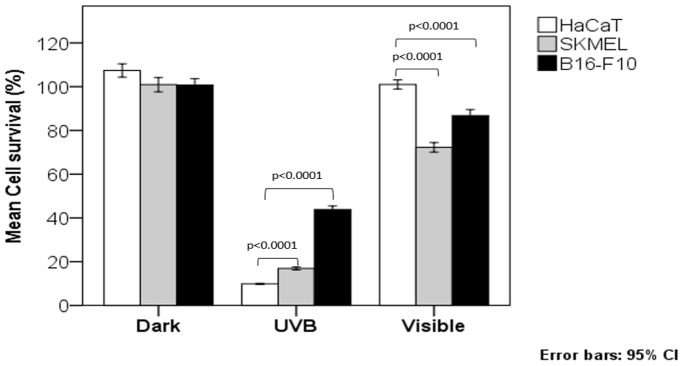
The effects of UVB and visible light on cell viability.The cell viability (MTT) of HaCaT, SK-mel and B16-F10 cells maintained in the dark (control) or irradiated with UVB (4.5 J.cm−2) or visible (36 J.cm−2) light. The color of the bars indicates the (qualitative) levels of melanin naturally produced by each cell line. Other cell lines, which are not melanocompetent (Hela, J774), were also tested and behaved similarly to the HaCaT cells (i.e., exhibited no phototoxicity from visible light at this dose (36 J.cm−2)).